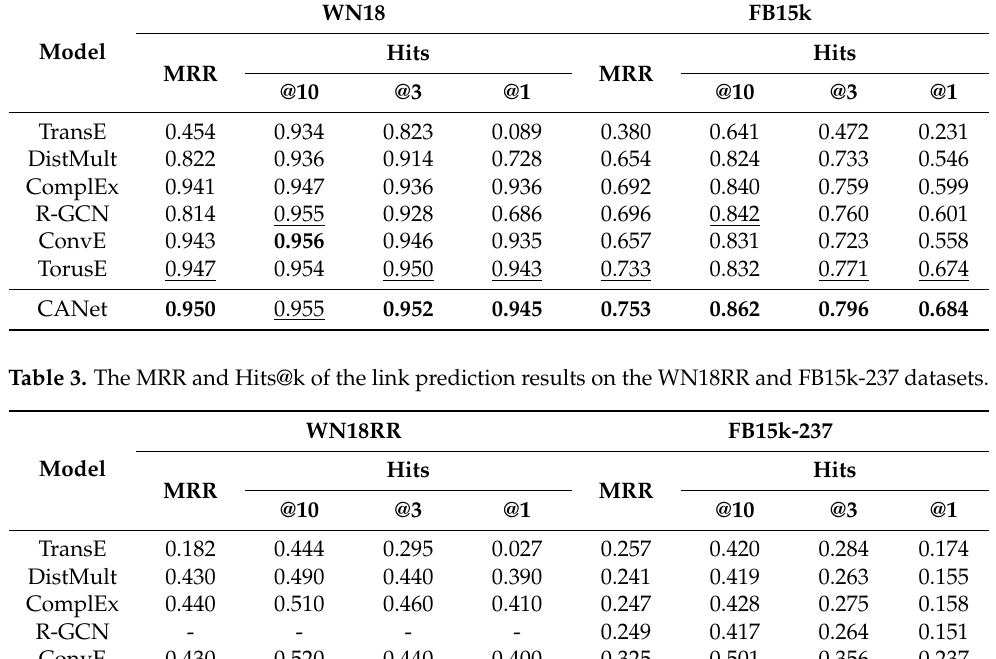
Table 2. The MRR and Hits@k of the link prediction results on the WN18 and FB15k datasets.